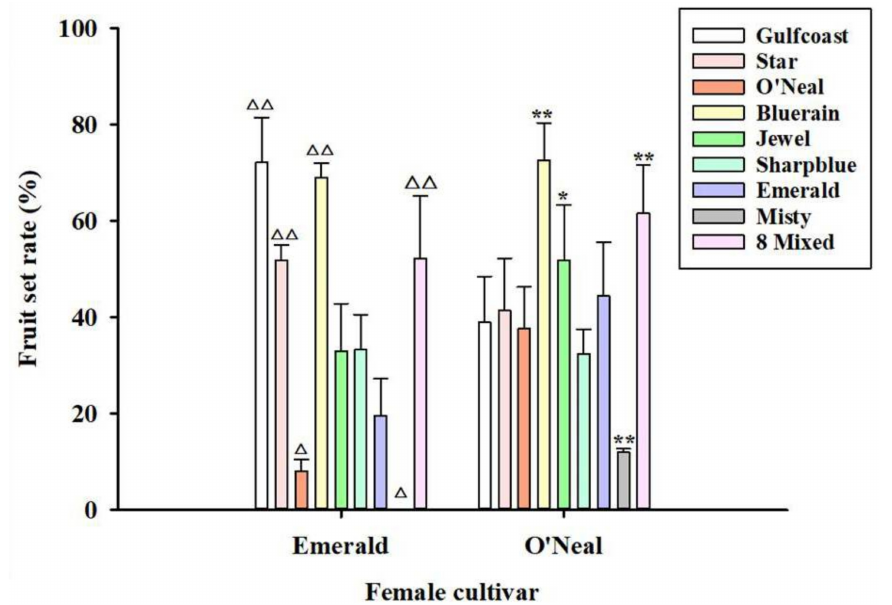
Figure 3. Xenia effect on the fruit set of ‘O’Neal’ and ‘Emerald’ from SHB. Fruit set of ‘O’Neal’ and ‘Emerald’ were compared when pollinated with different pollen donors. The X axis indicates different pollen donors. Note: (cid:52) p < 0.05, (cid:52)(cid:52) p < 0.01, compared to ‘Emerald’ × ‘Emerald’; * p < 0.05, ** p < 0.01, compared to ‘O’Neal’ × ‘O’Neal’. Bars sharing triangles or stars are significantly different from each other using the Duncan’s